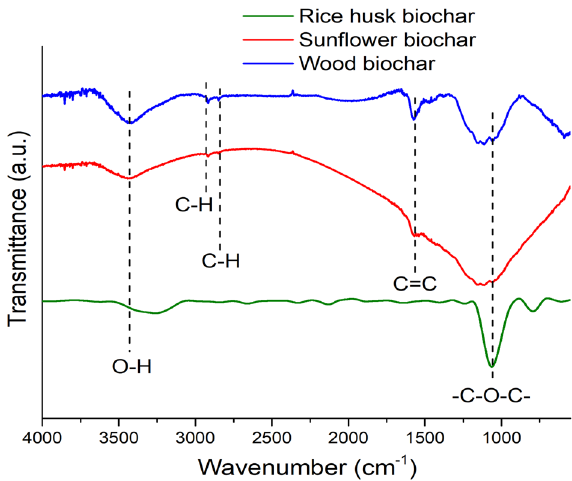
Figure 2. FTIR spectral characteristics of biochar from various raw